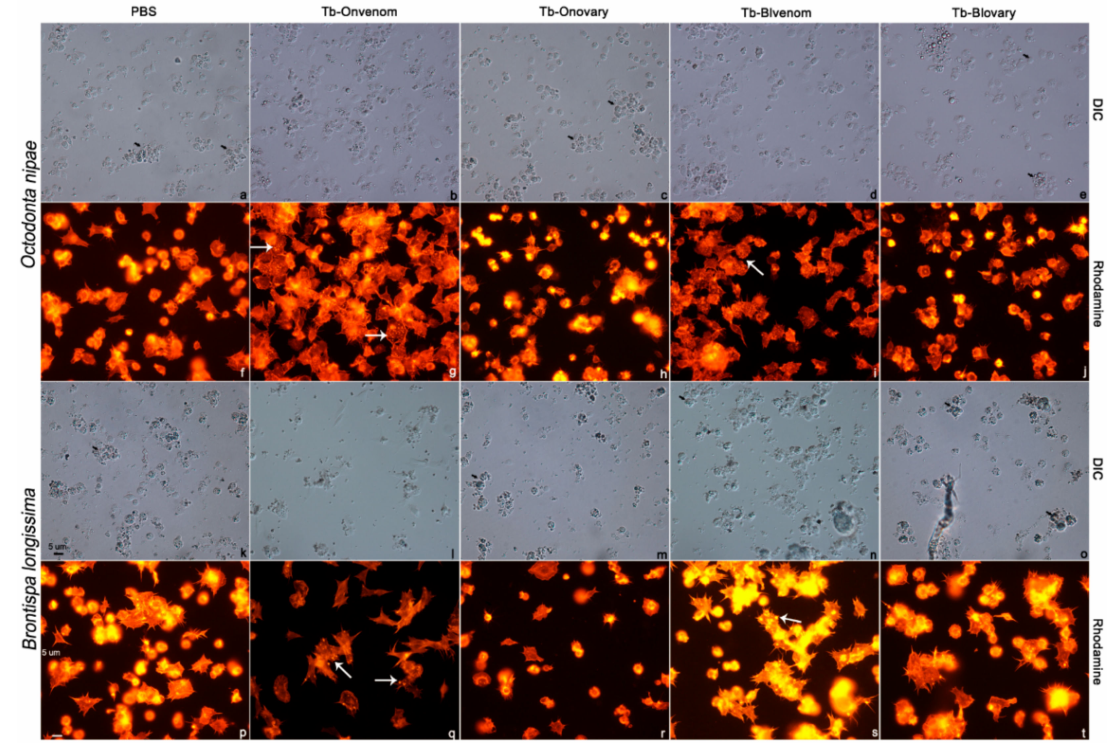
Figure 2. Haemocyte spreading assay in O. nipae and B. longissima pupae after the injection with virulent factors. ( a – e , k – o ) haemocytes visualised by differential interference microscopy; ( f – j , p – t ) fluorescence of rhodamine phalloidin-labelled cytoskeleton visualised by fluorescence microscopy. Star-like clusters in venom injection groups are marked by white arrows. Aggregates are marked by thick black arrows. Scale bars, 5 µ